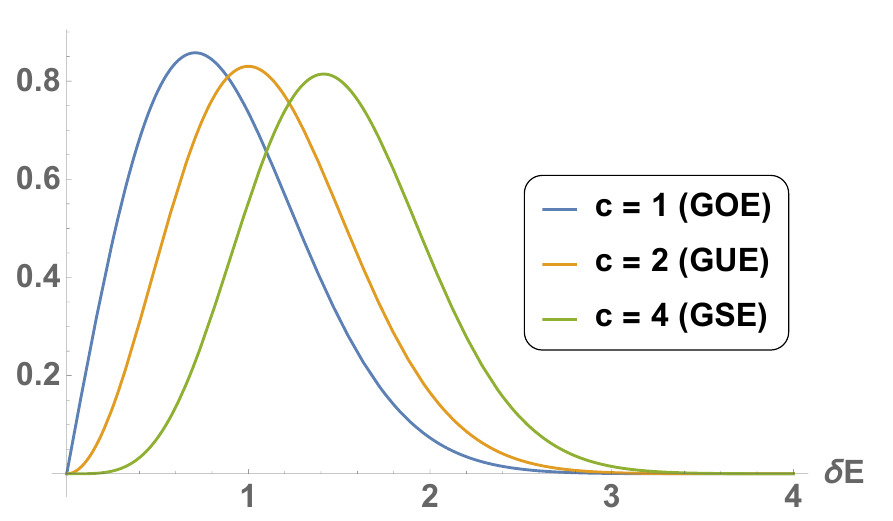
Figure 5 . The Wigner surmise NNS distribution for three ensembles. The Gaussian orthogonal ensemble (GOE) occurs when c = 1 . The Gaussian unitary ensemble (GUE) occurs when c = 2 . The Gaussian symplectic ensemble (GSE) occurs when c = 4